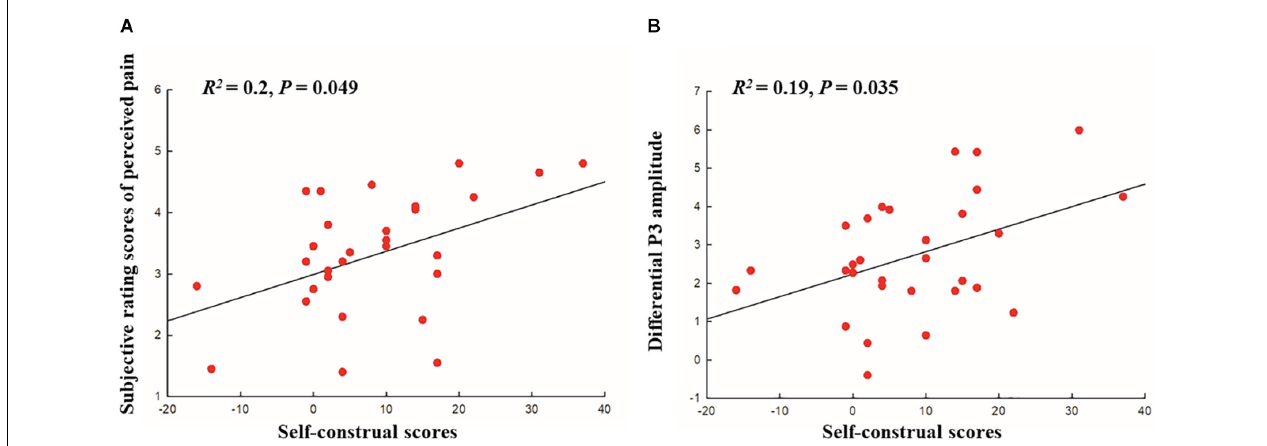
FIGURE 2 | (A) Scatter plot with correlation analysis between the self-construal scores (interdependence minus independence) and subjective ratings of perceived pain (painful minus no-painful stimuli), (B) Scatter plot with correlation analysis between the self-construal scores (interdependence minus independence) and the differential P300 amplitude at 400–500 ms (painful minus no-painful).